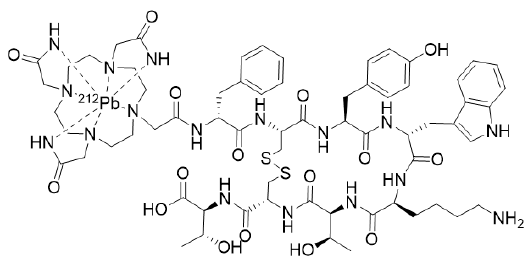
Figure 12. [ 212 Figure 12. [ 212 Pb]-DOTAMTATE.